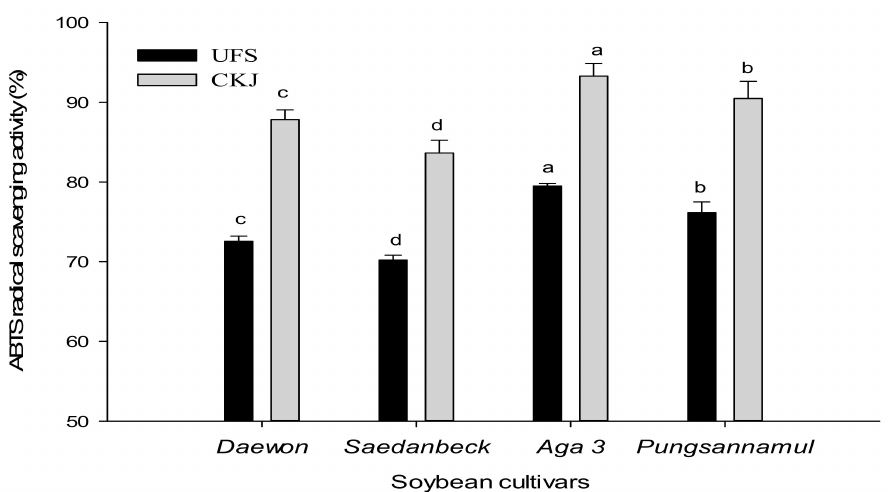
Figure 2. Changes in ABTS radical-scavenging activity between UFS and CKJ fermented by Bacillus subtilis (KCTC 13241) in different soybean cultivars. All values are means of three independent experiments. Means with different lowercase letters (a, b, c, and d) represent significant differences among cultivars by Duncan’s multiple range tests (DMRT) ( p <